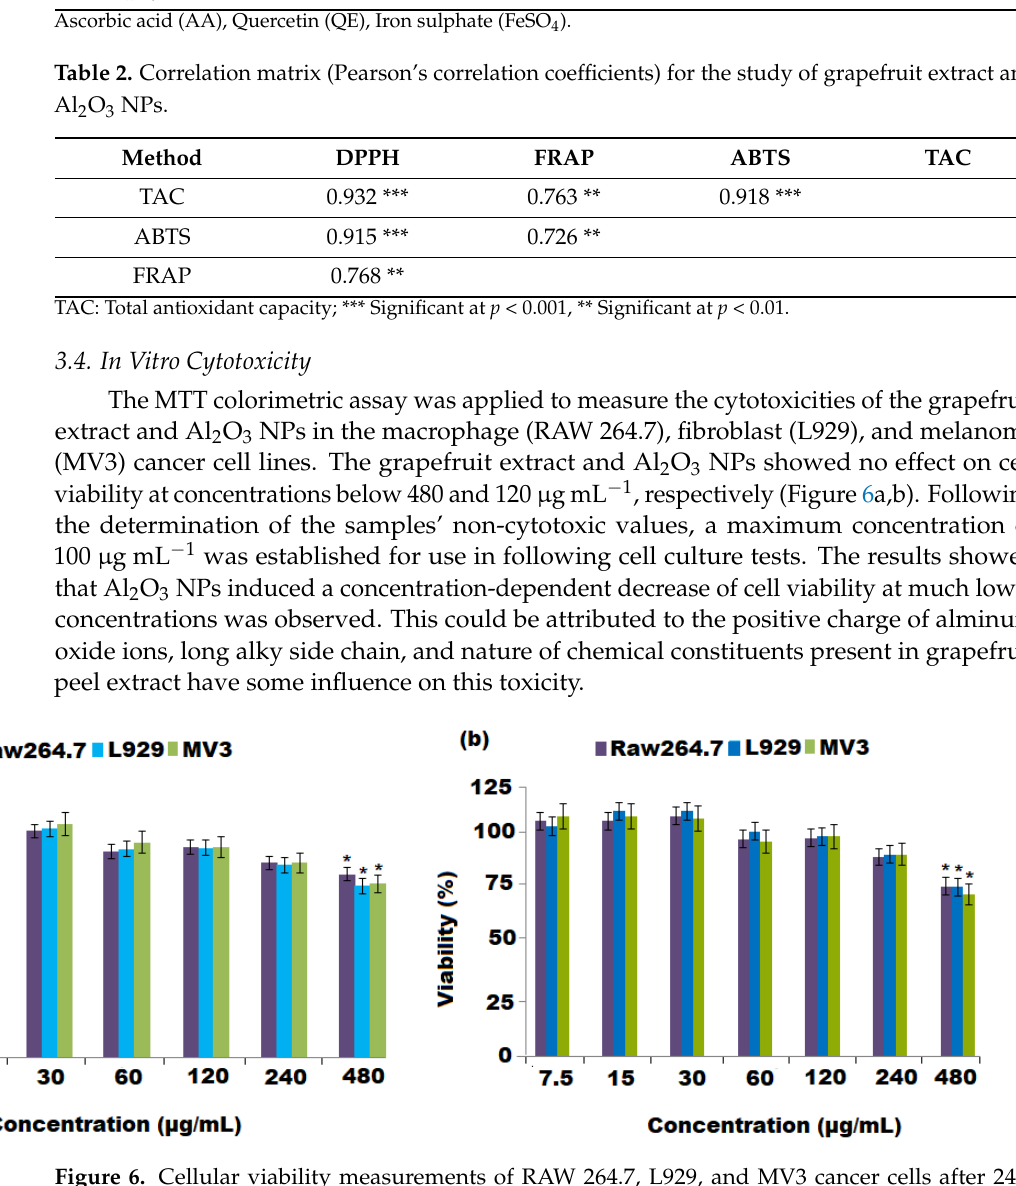
Figure 8. Effect of grapefruit peels extract and Al 2 O 3 NPs on the production ( a ) nitric oxide (NO) and ( b ) superoxide radical (O 2 •− ). ( a ) RAW 264.7 macrophages were treated to varied sample con- centrations and stimulated with LPS (1 μg mL −1 ) and ( b ) RAW 264.7 macrophages were treated to varied sample concentrations and stimulated with LPS after 30 min. L-NIL and tempol were used as positive control for NO and superoxide radical (O 2 •− ), respectively. The results were expressed as mean ± SD ( n = 2). # Significant ( p < 0.05) and * Significant ( p < 0.05) compared to the negative control without LPS and LPS-induced cells by one-way ANOVA followed by Tukey's post hoc test.